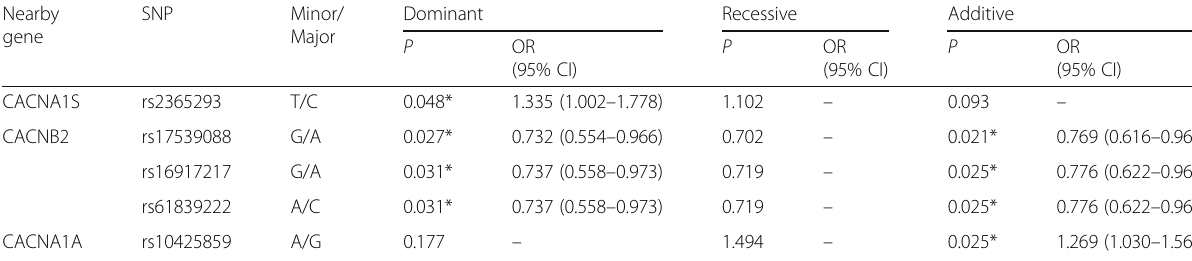
Table 3 Relation of SNPs to hypertension as determined by multivariable logistic regression analysis Nearby SNP Minor/ Dominant Recessive gene Major